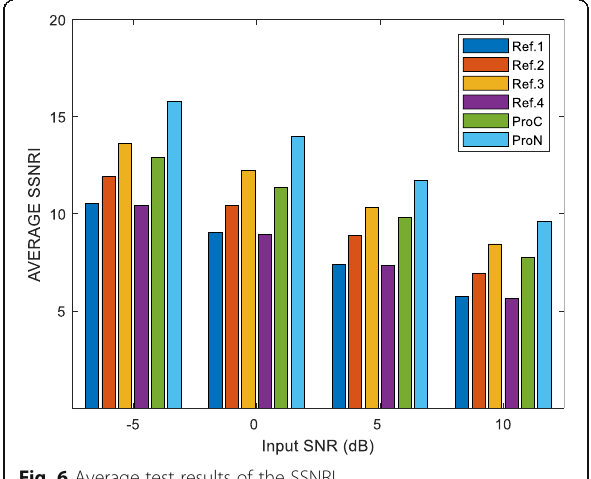
Fig. 6 Average test results of the